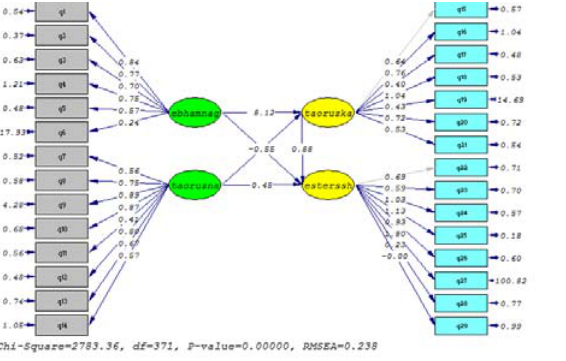
Fig. 3. Model estimation and path coefficients existing between variables